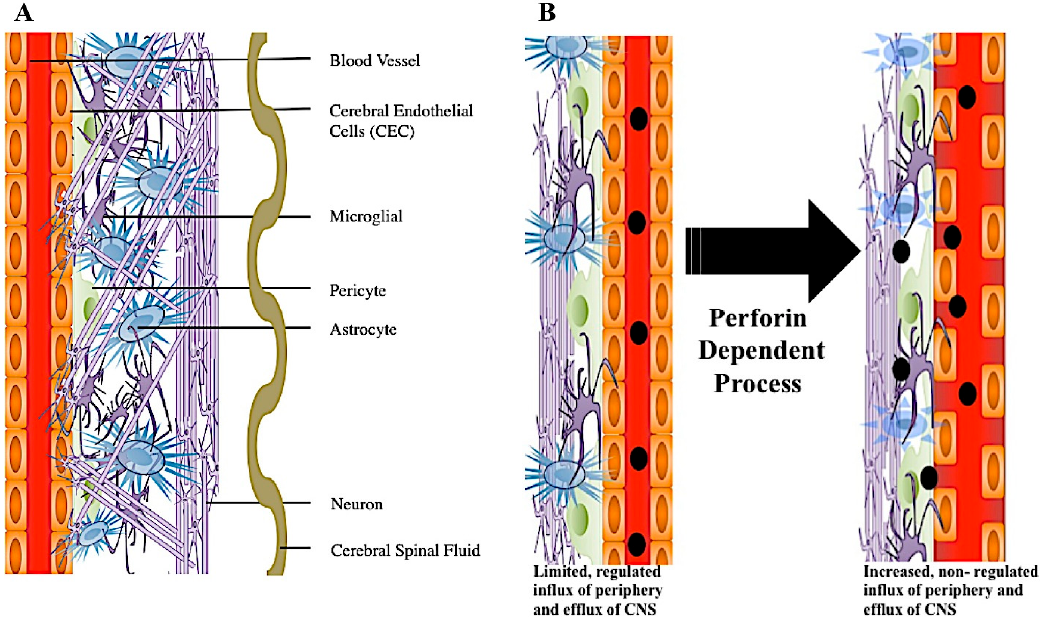
Figure 4. 2D representation of perforin mediated disruption of the blood–brain barrier. Surrounding the blood vessel is a layer of endothelial cells held together by tight junctions. Encompassing the enodthelial cell layer are various brain cells comprising the neural vascular unit (NVU). NVU cell types include pericytes, astrocytes, microglia, and neurons. Additionally, sinuses run through this dense environment carrying cerebral spinal fluid (CSF) throughout the brain ( A ). During neuroinflammation, the blood–brain barrier can be disrupted through a perforin dependent process. During this process, CEC tight junctions become disorganized and CNS permeability occurs. Where there was once vascular integrity and sequestration of the CNS, there is now increased non-regulated influx of molecules from the blood ( B ).